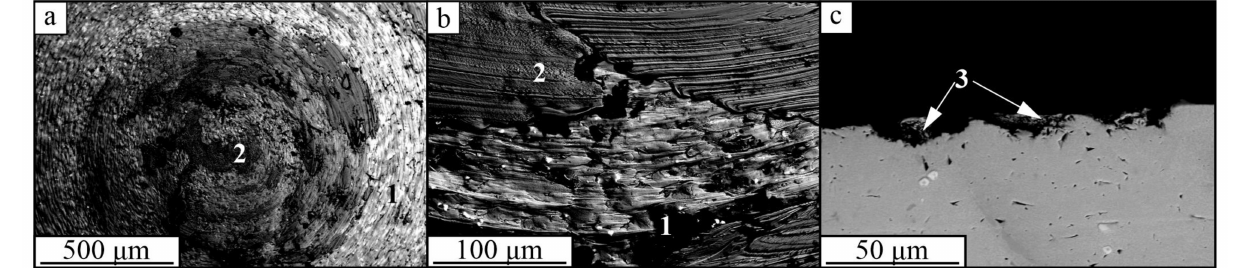
Figure 21. SEM BSE images of the pin end worn surface with transfer layer areas (( a , b ), pos. 2) and detached wear debris (( c ), pos.